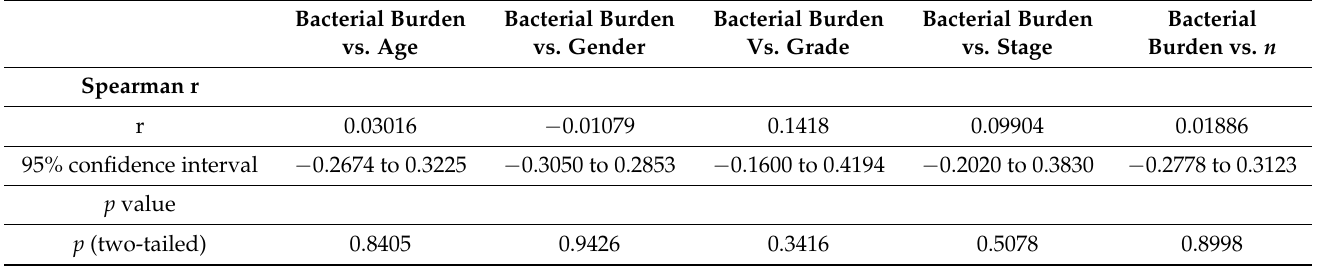
Table 4. Correlation analysis of the total bacterial burden with clinical and morphological characteristics. Bacterial Burden Bacterial Burden Bacterial Burden Bacterial Burden Bacterial vs. Age vs. Gender Vs. Grade vs. Stage Burden vs.